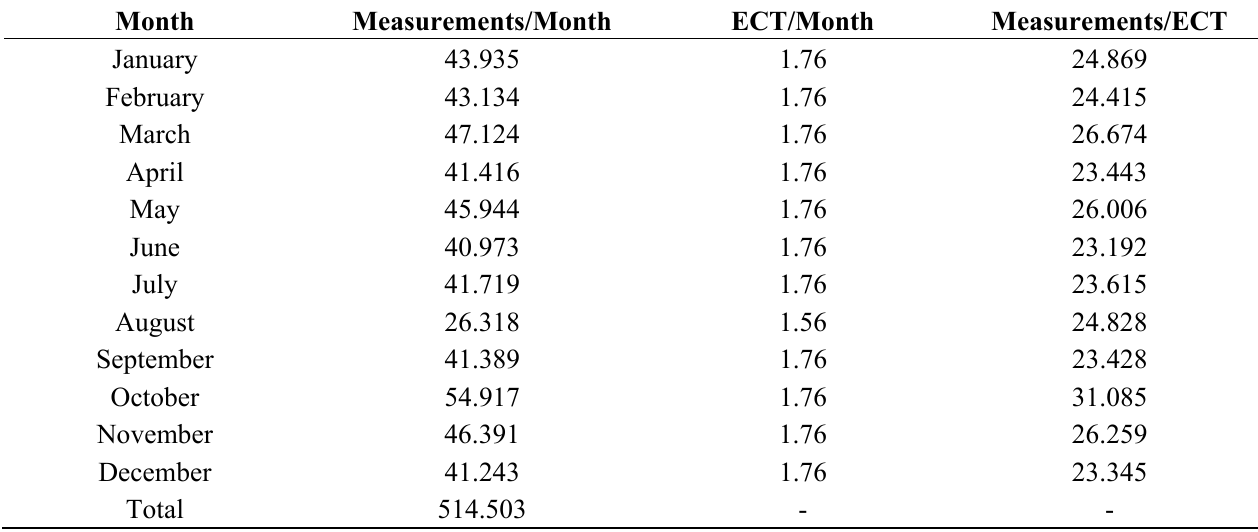
Table 3. Measurements performed during the year and number of ECT assigned with the calculation of Measurements per ECT. During the month of August we did not substitute the laboratory technicians and we brought assistance in ECT in the active